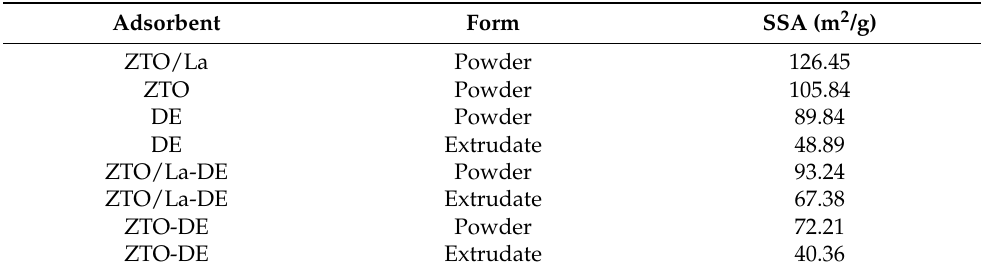
Table 2. SSA (m 2 /g) of ZTO/La, ZTO, DE, and